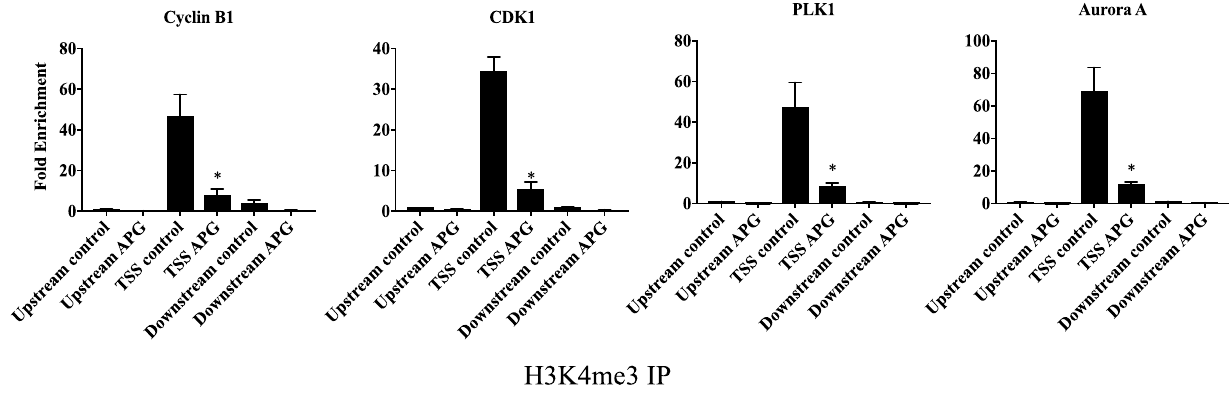
Fig. 6 Apigenin suppressed the transcription of the regulators that govern G to M phase transition. PC-3cells were treated with 0 µM or 25 2 µM of apigenin for 48 h and harvested for ChIP assay with anti-H3K4me3 antibody or rabbit IgG. The immuno-precipitated DNA samples were analysed by real-time PCR with primers targeting a region around transcription start site (TSS) and two negative control regions (the regions upstream and downstream to TSS). The data were shown as the mean ± SD from three different experiments. *p < 0.05 compared